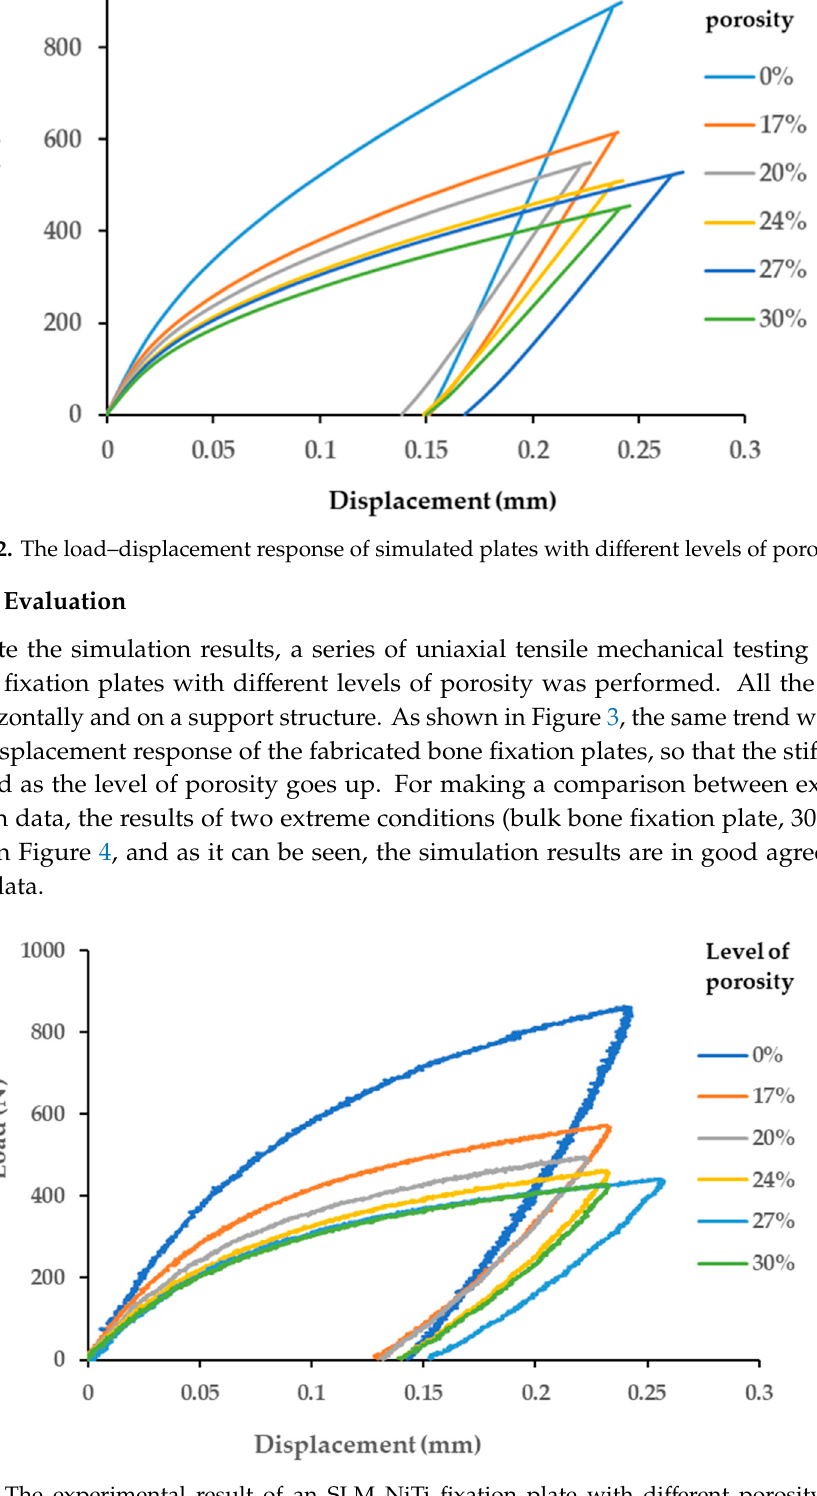
Figure 3. The experimental result of an SLM NiTi fixation plate with different porosity levels under tension.